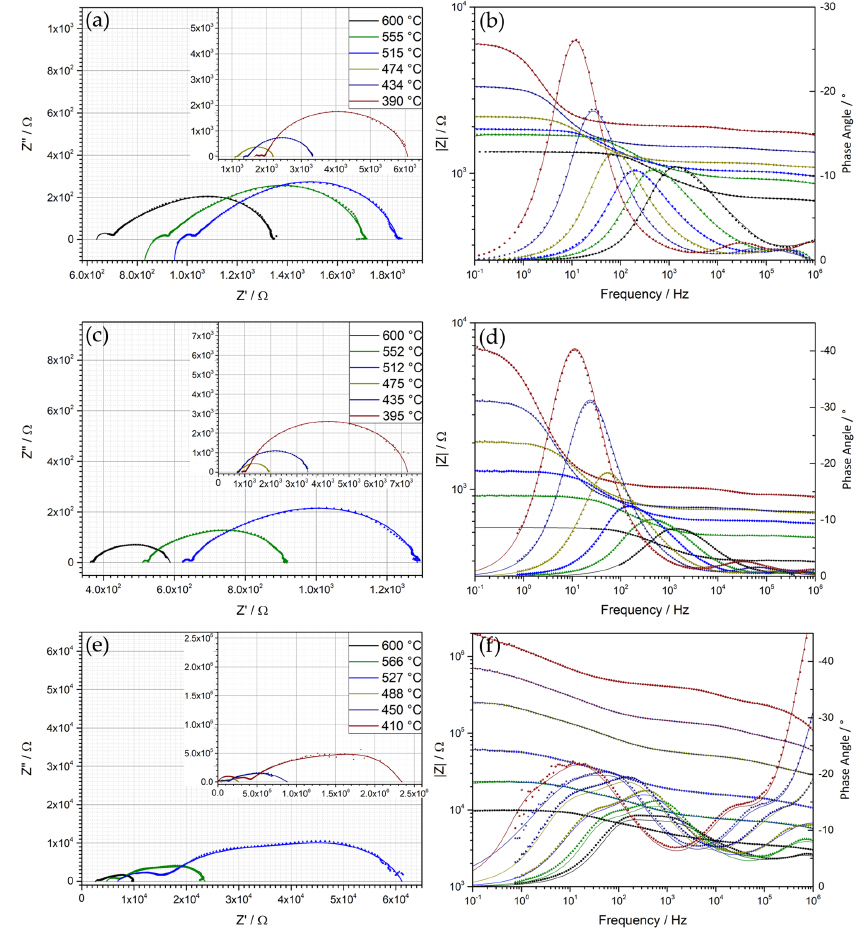
Figure 12. ( a , c , e ) Nyquist and ( b , d , f ) Bode plots of symmetrical films of BFO, BFOF33 and BFOF. The recorded data are represented by symbols, while the fits are drawn with solid lines.